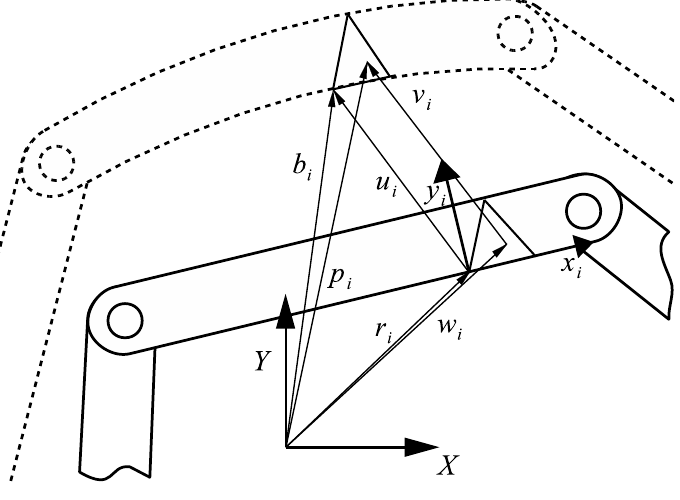
Figure 1. Kinematic definitions of the